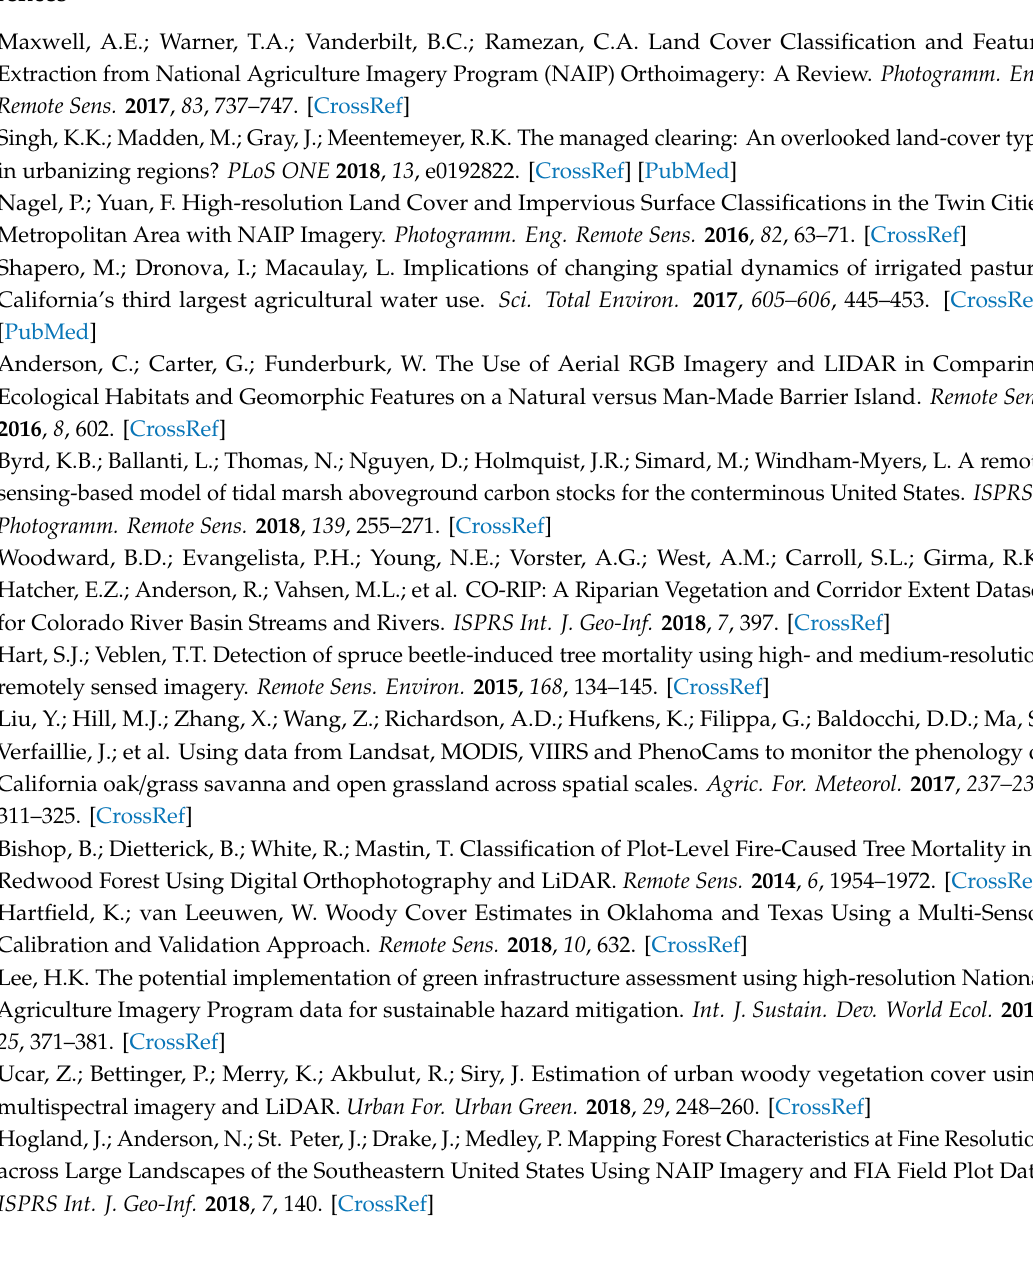
Table S1, Regression results based on PIV pixels at 150 sites; Table S2, NDVI validation results at 150 sites; Figure S1, Comparison of pixelwise 10-year standard deviations of surface reflectance in red, green and NIR bands at site 1; Figure S2, Comparison of ten-year NIR reflectance of PIV pixels and non-PIV pixels in vegetated areas at site